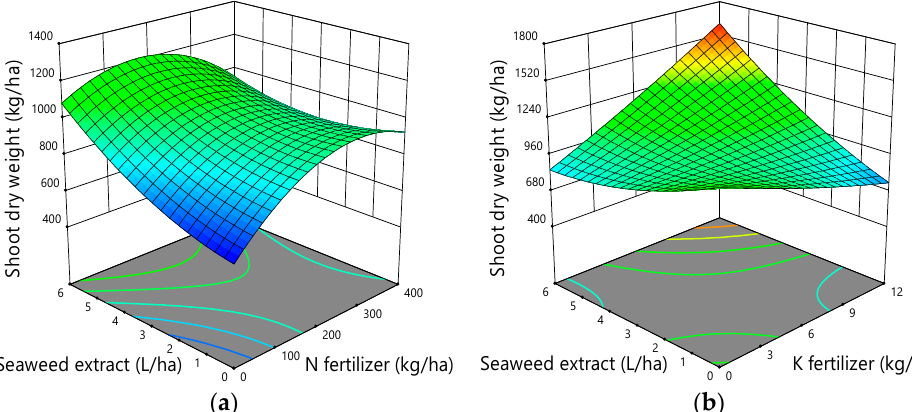
Figure 3. Response surface plots showing the interactive effects of N fertilizer and seaweed extract ( a ), and K fertilizer and seaweed extract ( b ) on the shoot dry weight of thyme. K fertilizer in ( a ), and N fertilizer in ( b ) was kept constant at 6 kg ha − 1 and 200 kg ha − 1 , respectively.